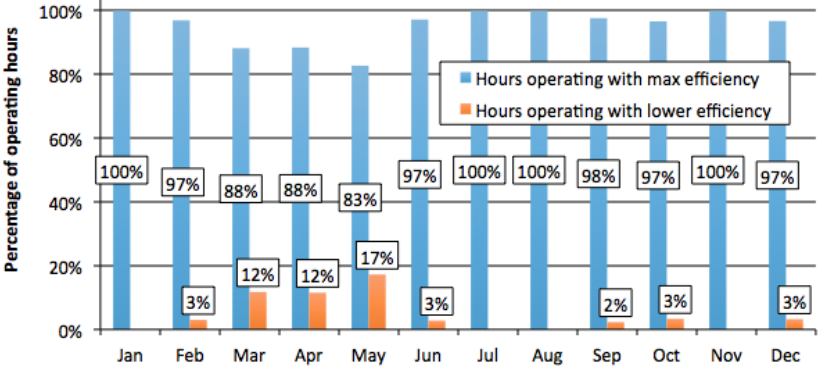
Figure 19. Percentage of diesel generators ’ operating hours inside and outside the maximum efficiency region in the TO-BE scenario 2. Table 3. Operating hours of diesel generators in the TO-BE scenario 2.